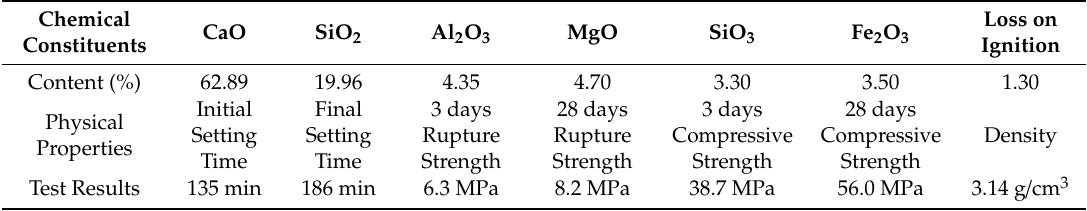
Table 1. The major chemical constituents and physical properties of the cement.